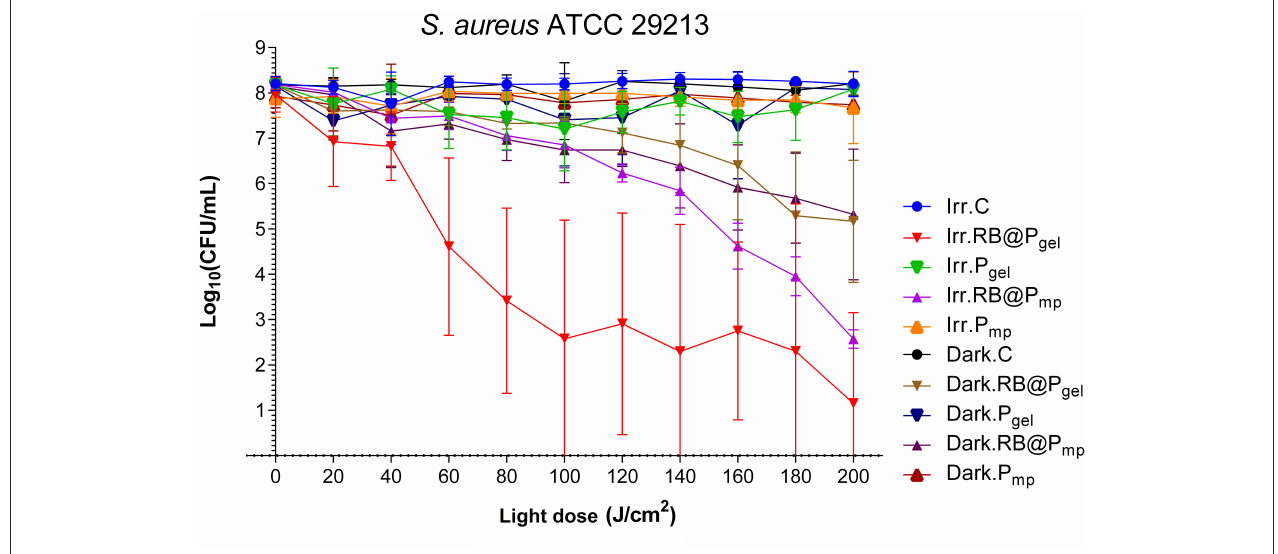
FIGURE 2 | Survival curves corresponding to the photodynamic inactivation of Staphylococcus aureus . Every point is the average of three independent experiments. Error bars correspond to the standard deviations. Legend titles: Irr , irradiated samples; Dark , controls in the darkness; C , control, only microbial suspension; RB@P gel , Amberlite ® IRA-400 (P gel ) loaded with Rose Bengal (RB); P gel , P gel resin without RB; RB@P mp , Amberlite ® IRA-900 (P mp ) loaded with RB; P mp , P mp resin without RB.